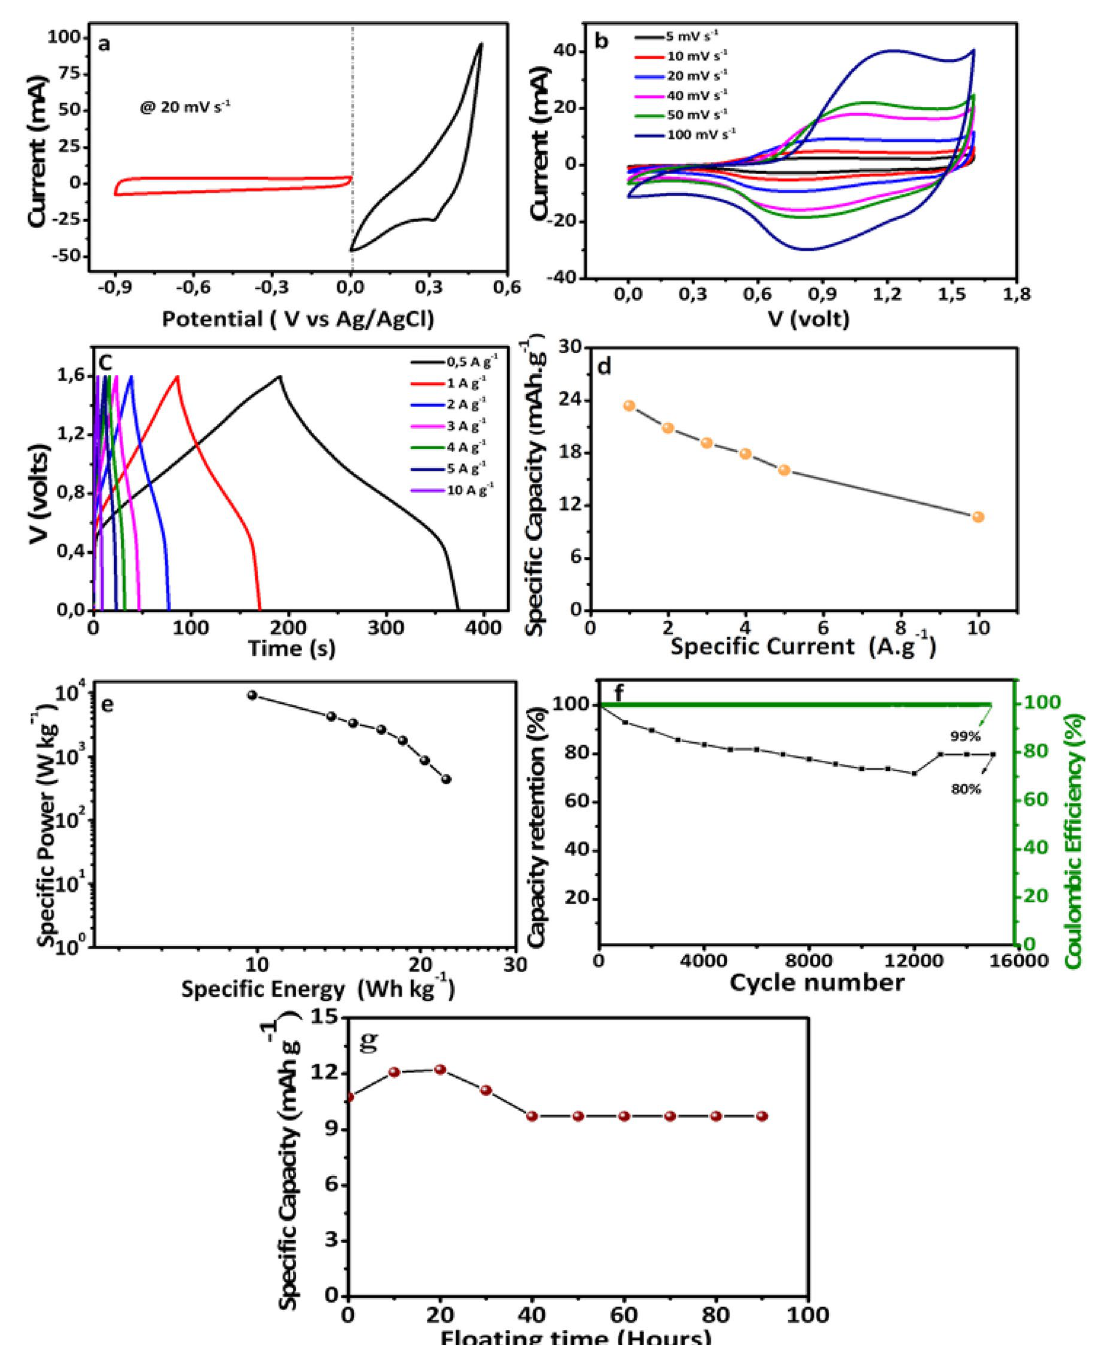
Fig. 10 a CV curves at 20 mV s −1 of the positive and negative elec- trodes, b device’s CV curves at different scan rates, c device’s GCD curves at different specific currents, d device’s specific capacity ver-